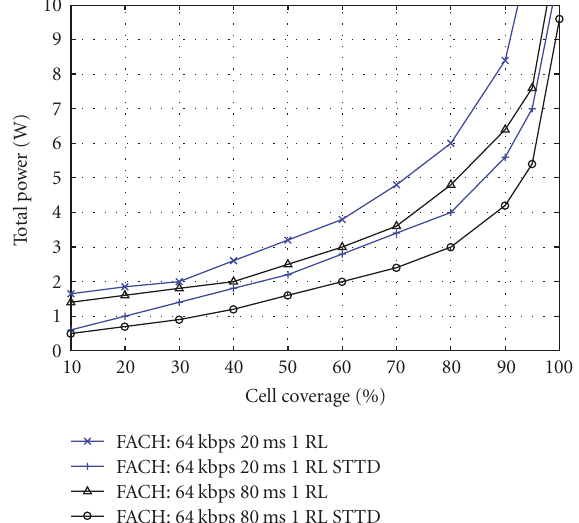
Figure 5: FACH Tx power with macrodiversity combining (1RL, 2RLs and 3RLs).